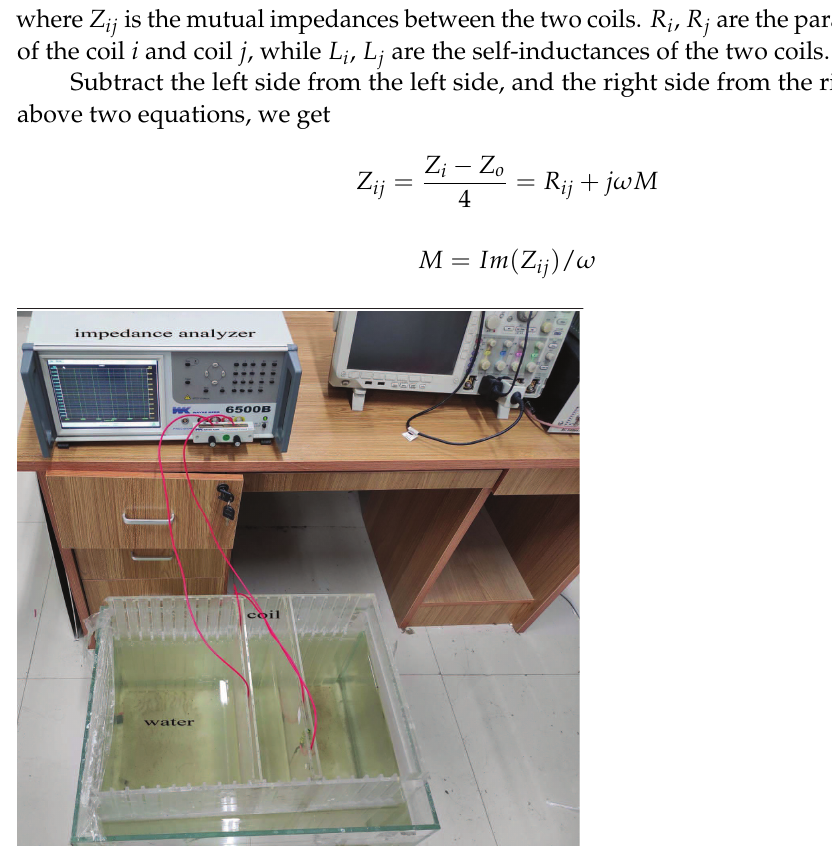
Figure 5. Image of the experimental